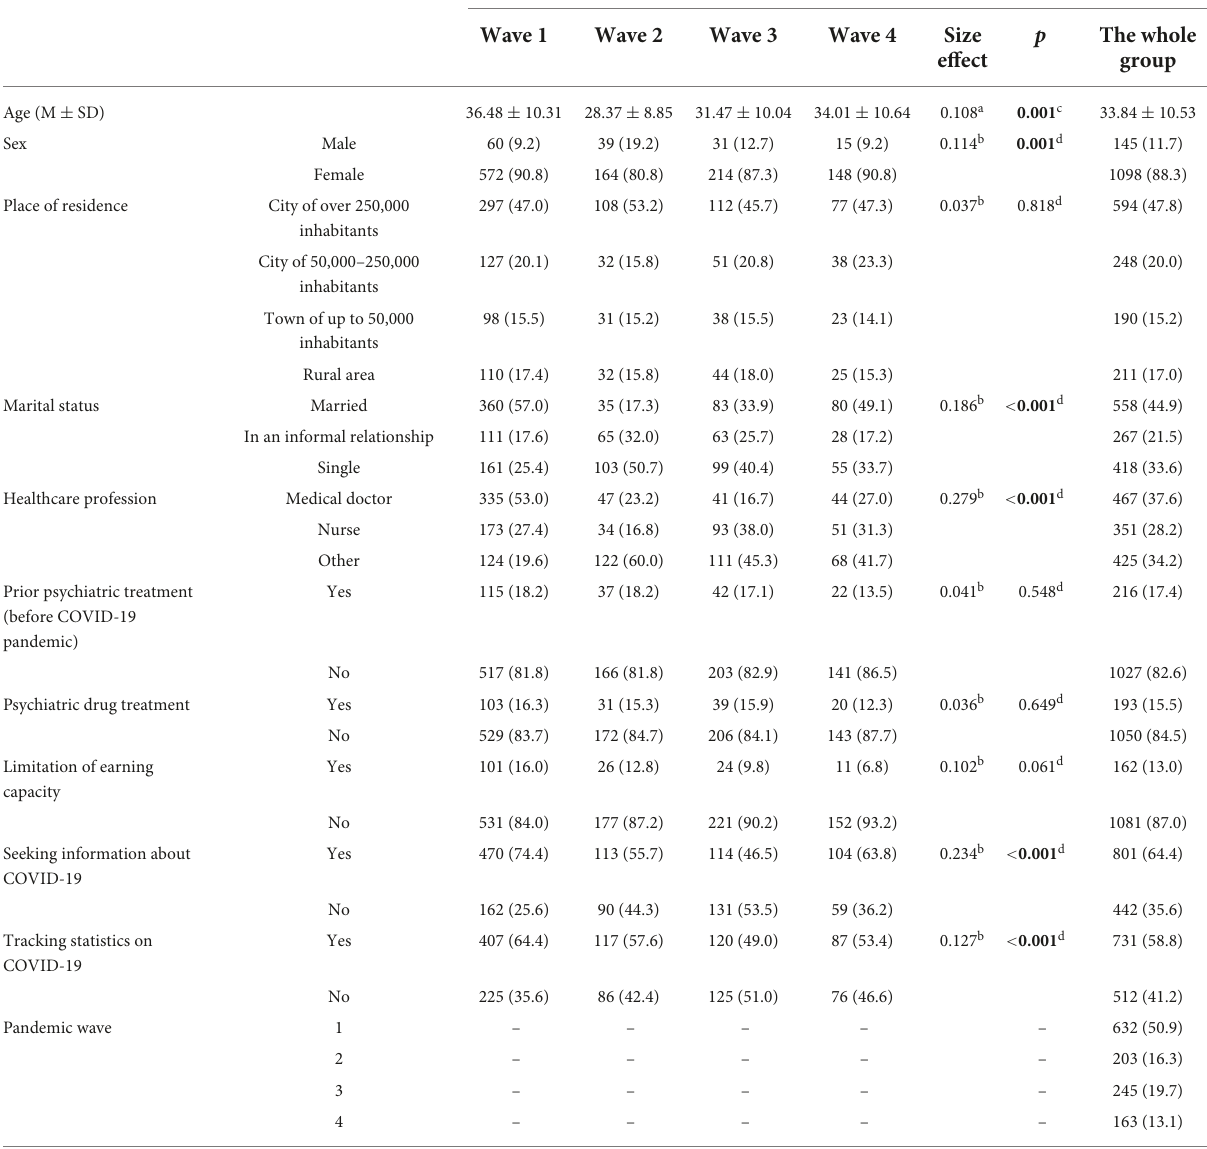
TABLE 1 Characteristics of the study